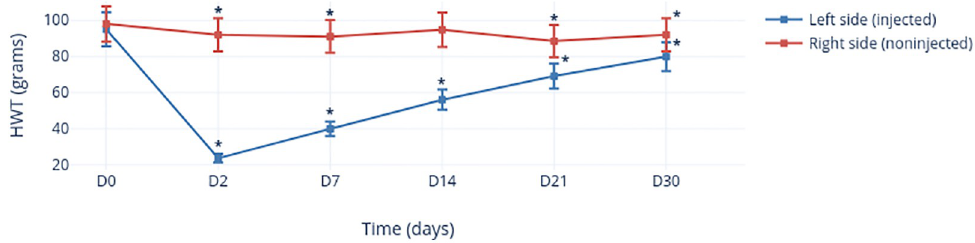
Fig 5. Change in the HWT of TMJs with/without Col-2 injection as a function of time. � Significant values.